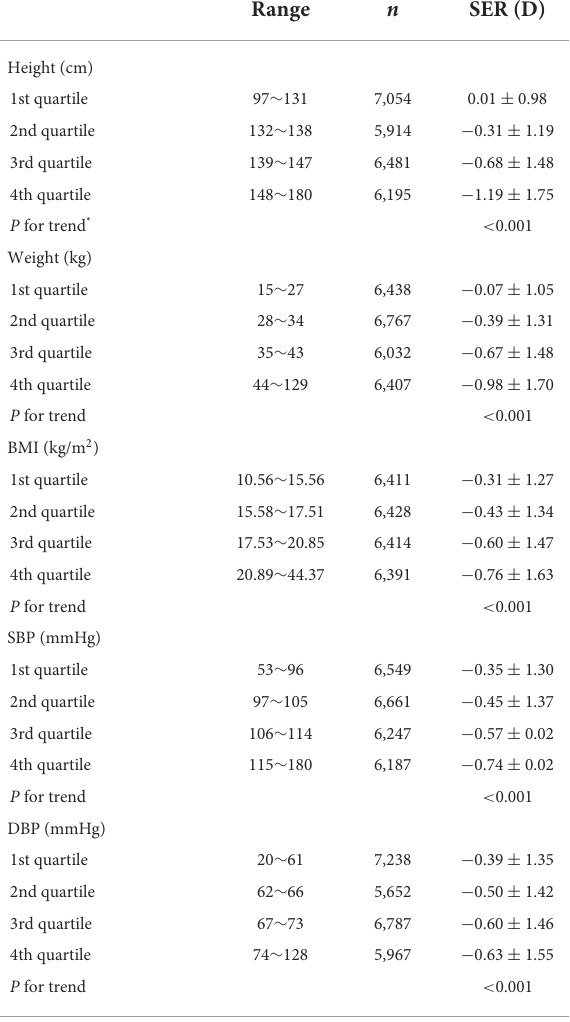
TABLE 3 Mean values of SER by quartiles of height, weight, BMI, SBP, and DBP.